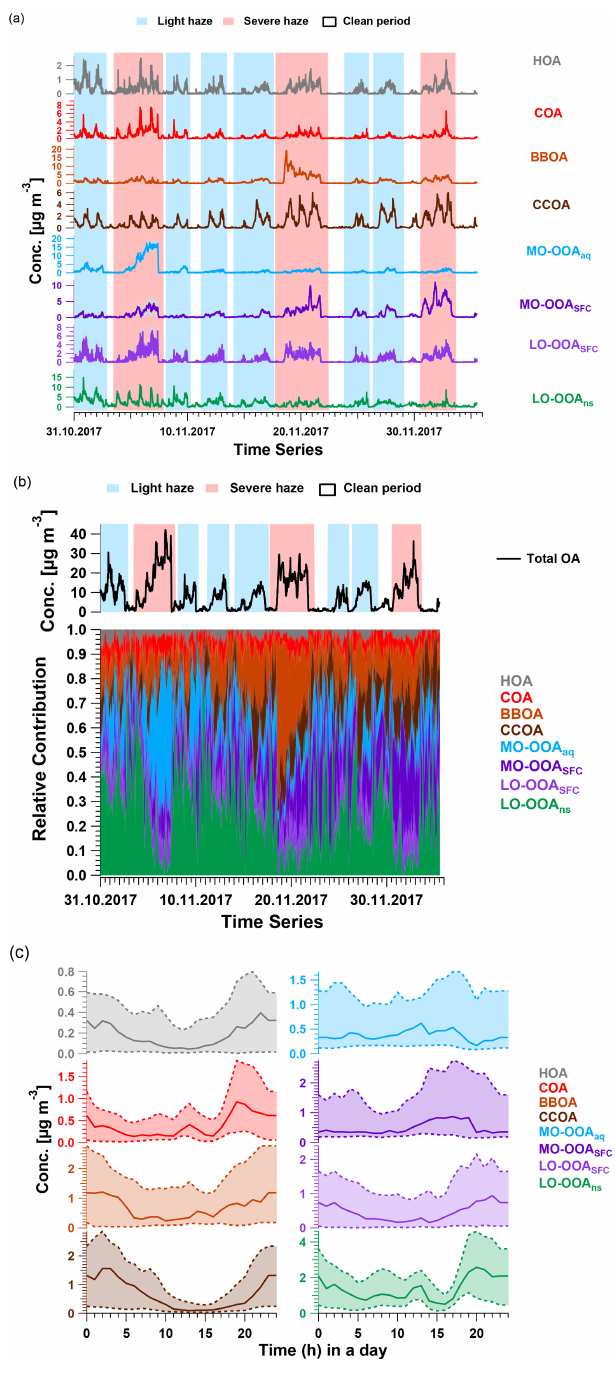
Figure 3. (a) Averaged time series with interquartile range (shaded area with same colour as factor), (b) averaged total OA concen- tration and relative contributions and (c) median diurnal cycle the accepted AMS PMF bootstrap eight-factor solutions based on the criteria discussed in Sect. 2.3. Lower and upper dashed lines in (c) indicate first and third quantiles. In (a) and (b) , the shaded areas in red and in blue represent periods of severe haze and light haze,